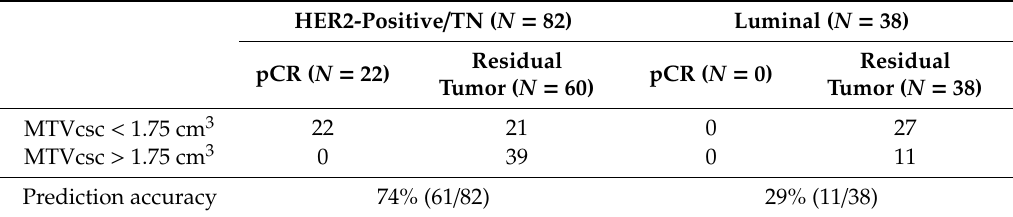
Table 3. Prediction of tumor response to NAC using MTVcsc in HER2-positive / TN vs. luminal